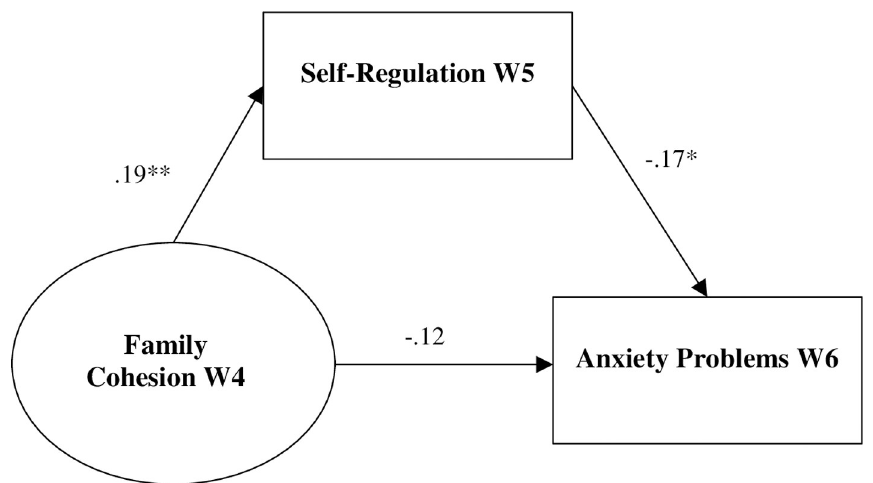
Fig 2. Indirect effects model. Standardized results are presented. Family cohesion at W3, self-regulation at W4, and anxiety problems at W5 were controlled for in the model but removed from the figure for clarity. � p < .05 (two- tailed). �� p < .01 (two-tailed). ��� p < .001 (two-tailed).